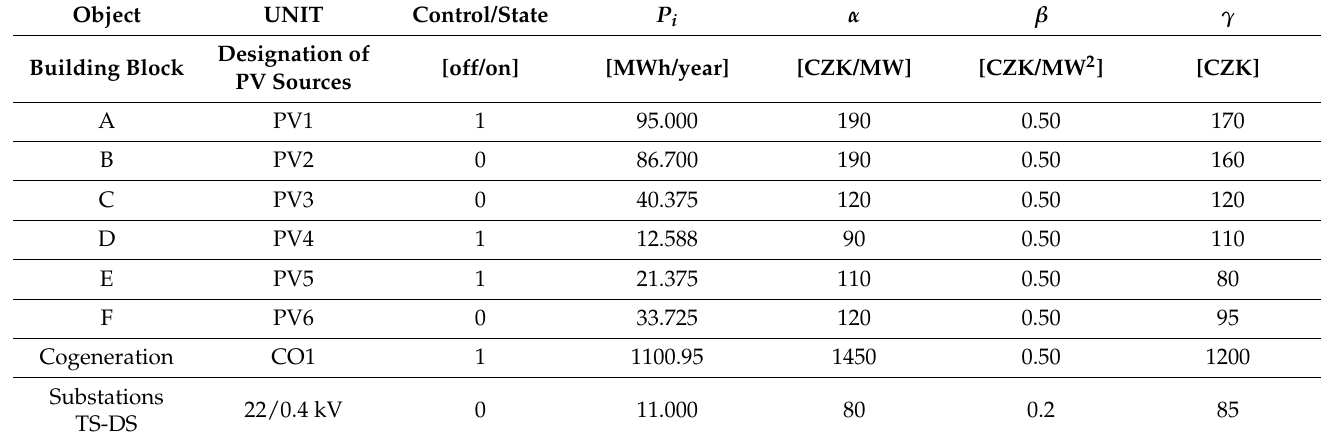
Table 2. RES Parameters by Individual Building Cluster Blocks.